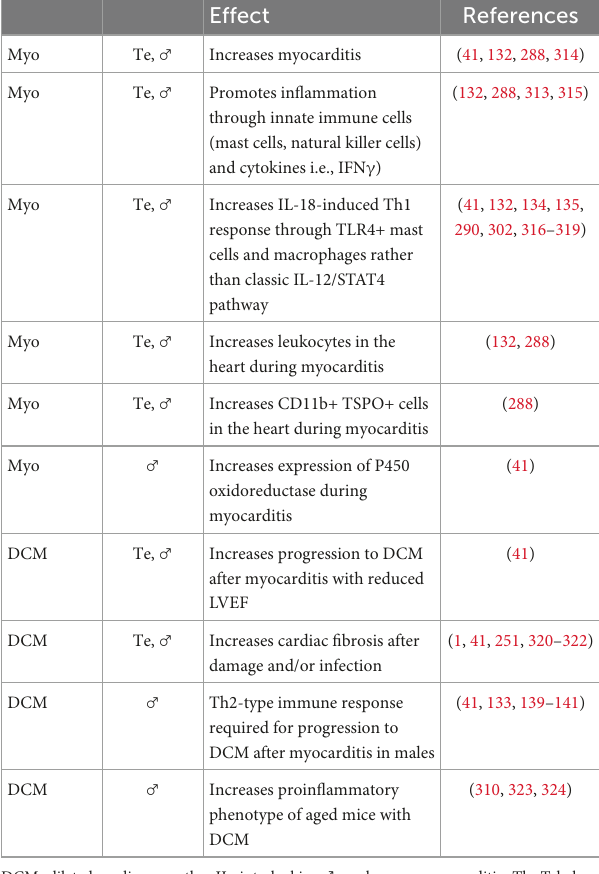
TABLE 6 Effect of testosterone and/or male sex on an inflammatory response or myocarditis from animal models or tissue